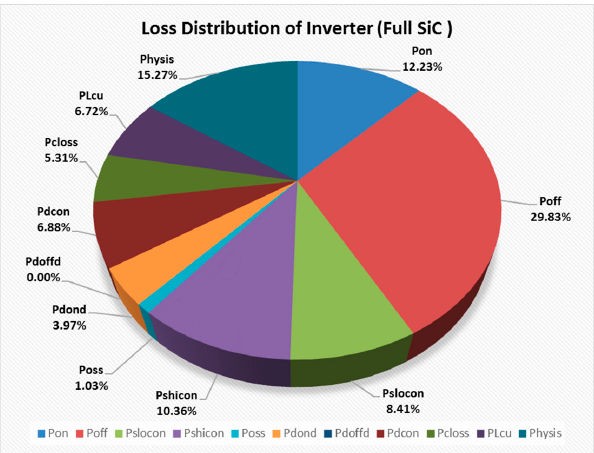
Figure 7. Loss distribution of Example 1.